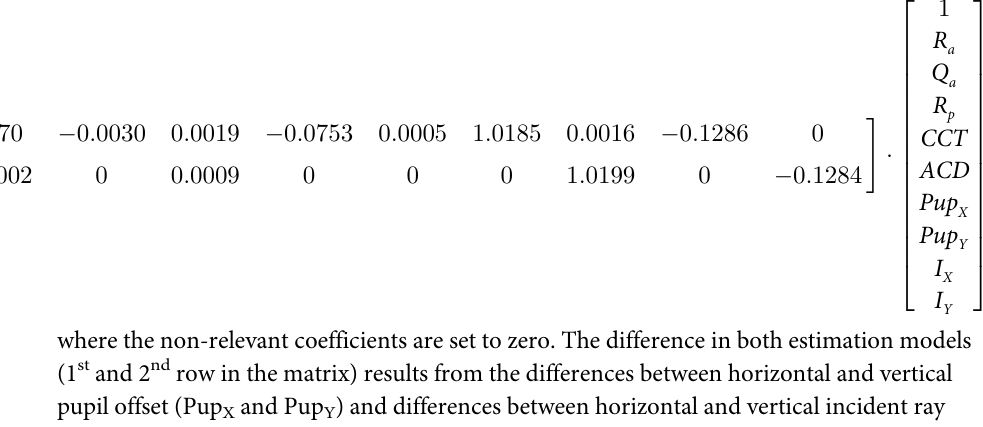
CW in green). The respective histograms are plotted on the diagonal of the matrix. The relevant Y effect sizes for CW are the anterior and posterior corneal curvature Ra and Rp, asphericity of X corneal front surface Qa, central corneal thickness CCT, anterior chamber depth ACD, position of the pupil centre Pup and Pup , and the incident ray angle I . The relevant effect sizes for X Y X CW are identified for anterior and posterior corneal curvature Ra and Rp, position of the pupil Y centre Pup , and incident ray angle I . The graph shows that there is a good correlation between Y Y Ra and Rp, whereas Qa and Qp are not correlated and show no dependency on Ra or Rp.